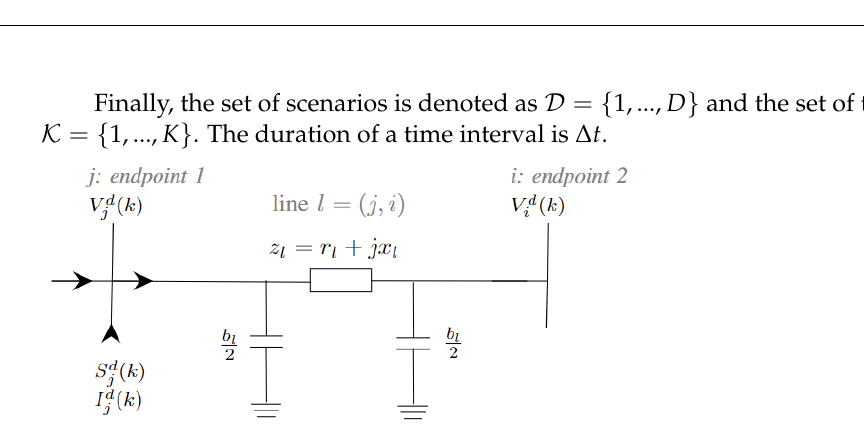
Figure 1. π model of the distribution line.